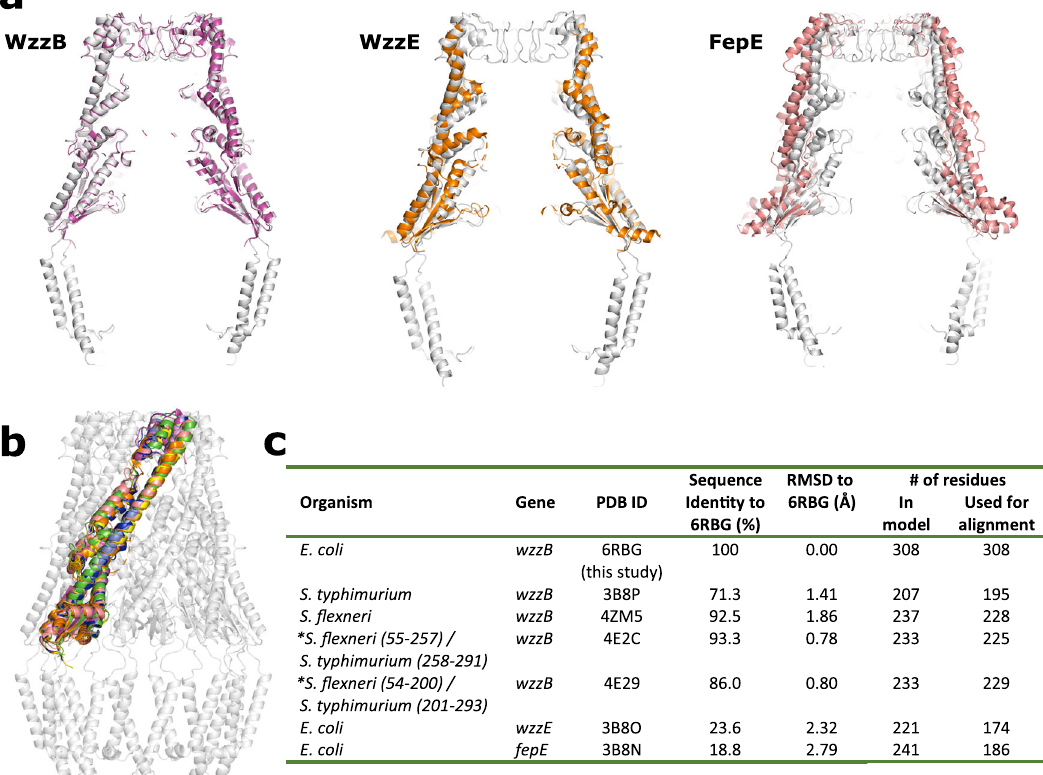
Fig. 3 Comparison of PCP periplasmic domain models to the full-length WzzB. a Structural alignment of representative periplasmic models that crystalized in the octameric WzzB 4E29 (magenta), WzzE 3B8O (orange), and the nonameric FepE 3B8N (salmon) oligomeric state onto the full-length WzzB 6RBG (gray). b Structural alignment of protomers regardless of oligomeric state that they crystallized in onto the full-length WzzB 6RBG. The PDB codes used for alignment are: 3B8P (yellow), 4ZM5 (green), 4E2C (blue), 4E29 (magenta), 3B8O (orange), and 3B8N (salmon). c Table comparing the structural alignment of the protomers in ( b ). *Chimeric S. fl exneri / S. typhimurium WzzB, values in parenthesis are the amino acid residue ranges coming from each WzzB protein 13 . Protomers were aligned and RMSD was calculated using Coot ’ s 44 SSM Superpose function.